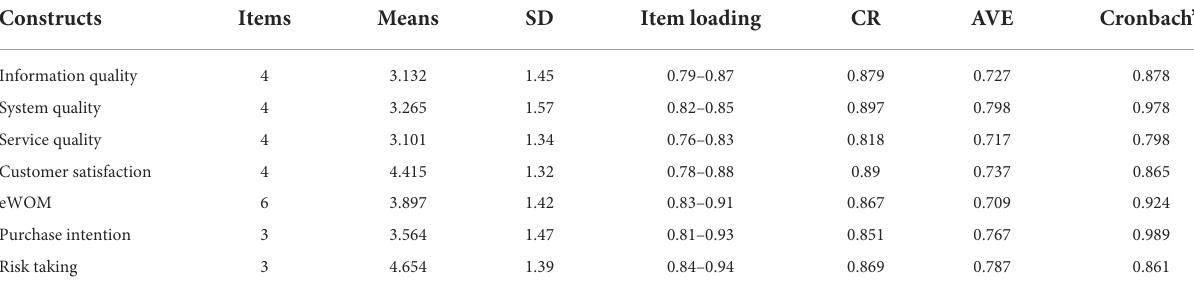
TABLE 3 Reliability and convergent validity.